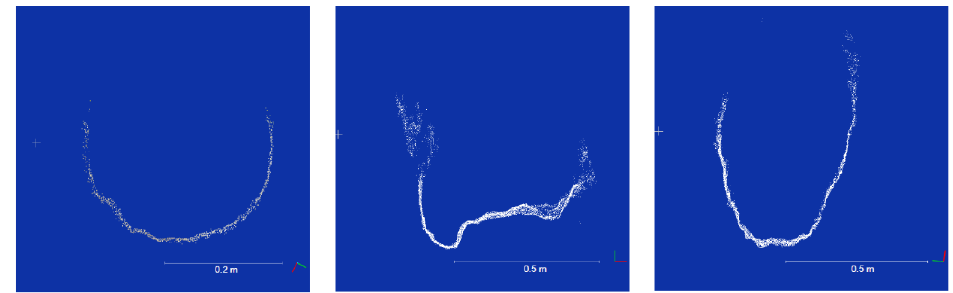
Figure 6. Point cloud stem slices used for measuring a highly-circular stem ( left ) and irregular-shaped stems ( center and right ).